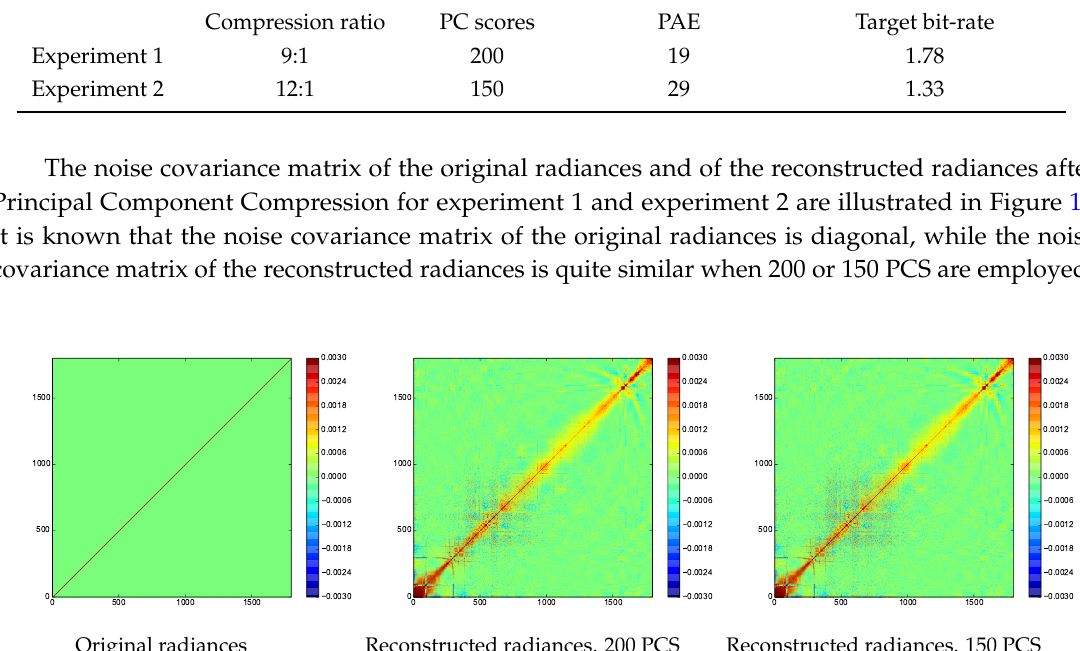
Figure 14. Noise covariance matrix of the original radiances and noise covariance matrix of the reconstructed radiances after Principal Component Compression when 200 and 150 PCS are